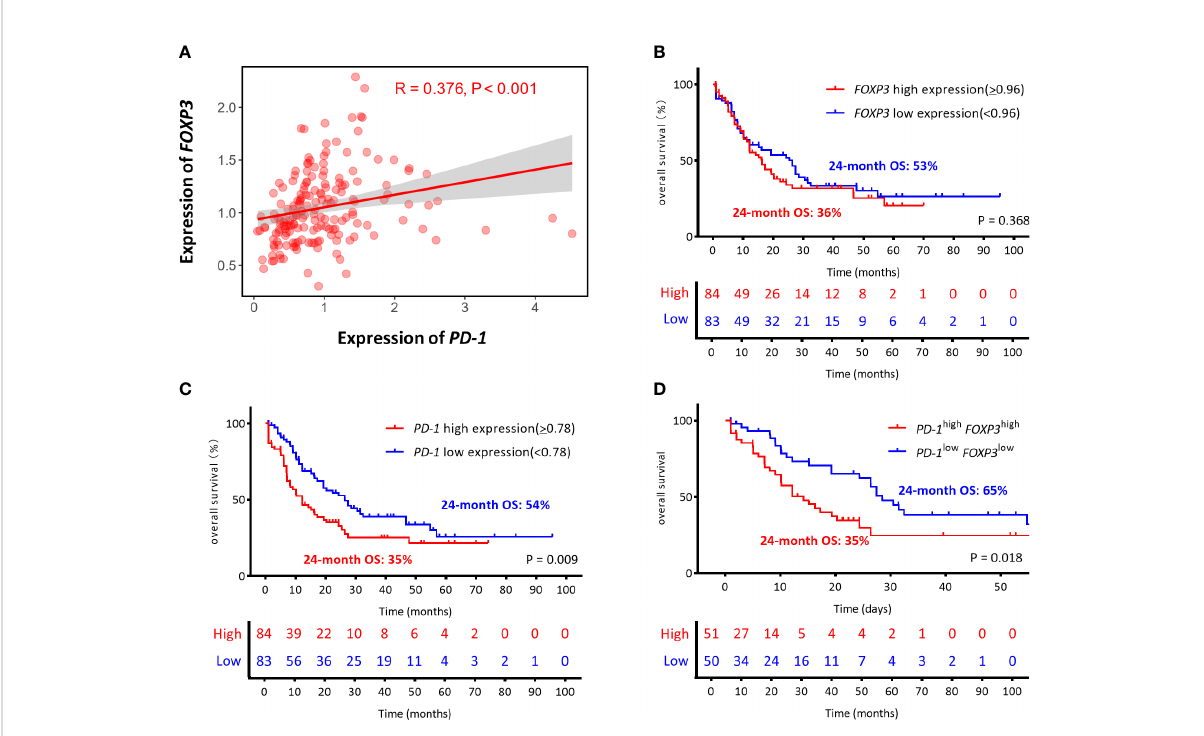
FIGURE 1 The correlation and the prognostic between the expression of PD-1 and FOXP3 genes in AML from the TCGA (The Cancer Genome Atlas). (A) Correlation of the expression levels of PD-1 and FOXP3 . (B – D) The optimal cutoff values were based on the median gene expression levels, the FOXP3 and PD-1 genes were divided into high expression (red line) and low expression (blue line) groups, which were plotted in Kaplan-Meier curves (top) with the number at risk AML patients (bottom). Kaplan-Meier curves are shown for single FOXP3 high or low expression, single PD-1 high or low expression, and co-high or co-low expression of PD-1/FOXP3 . (B) FOXP3 high vs. FOXP3 low , 24-month OS: 36% vs. 53% P = 0.368. (C) PD-1 high vs. PD-1 low , 24-month OS: 35% vs. 54% P = 0.009. (D) PD-1 high FOXP3 high vs. PD-1 low FOXP3 low , 24-month OS: 35% vs. 65% P =